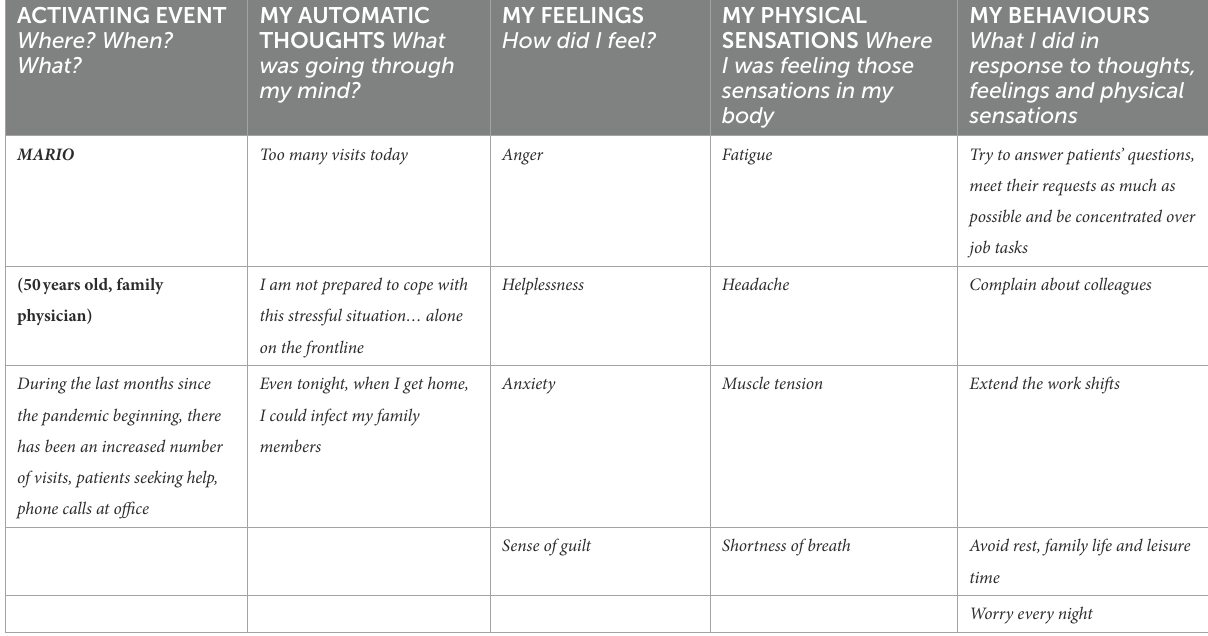
TABLE 1 Example of an ABC daily diary completed by a fictional healthcare worker (Mario). ACTIVATING EVENT Where?